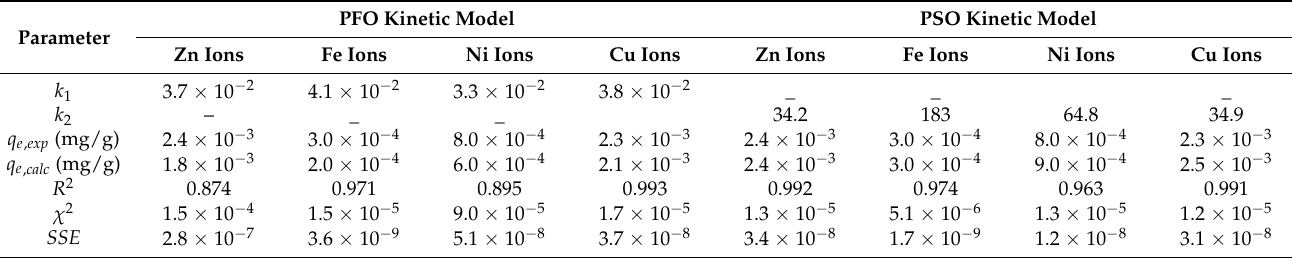
Figure 10. The variation of the removal capacities with time for the removal of Zn, Fe, Ni, Cu ions from a desalination plant outfall brine discharge by HS nanoclay. (Experimental conditions: 60.0 mL solution, pH 8.0, 150 mg dosage, and 298 K). Table 1. Parameters of the pseudo-first-order (PFO), and pseudo-second-order (PSO) kinetic models for the removal of Zn, Fe, Ni, Cu ions from the outfall brine sample using HS